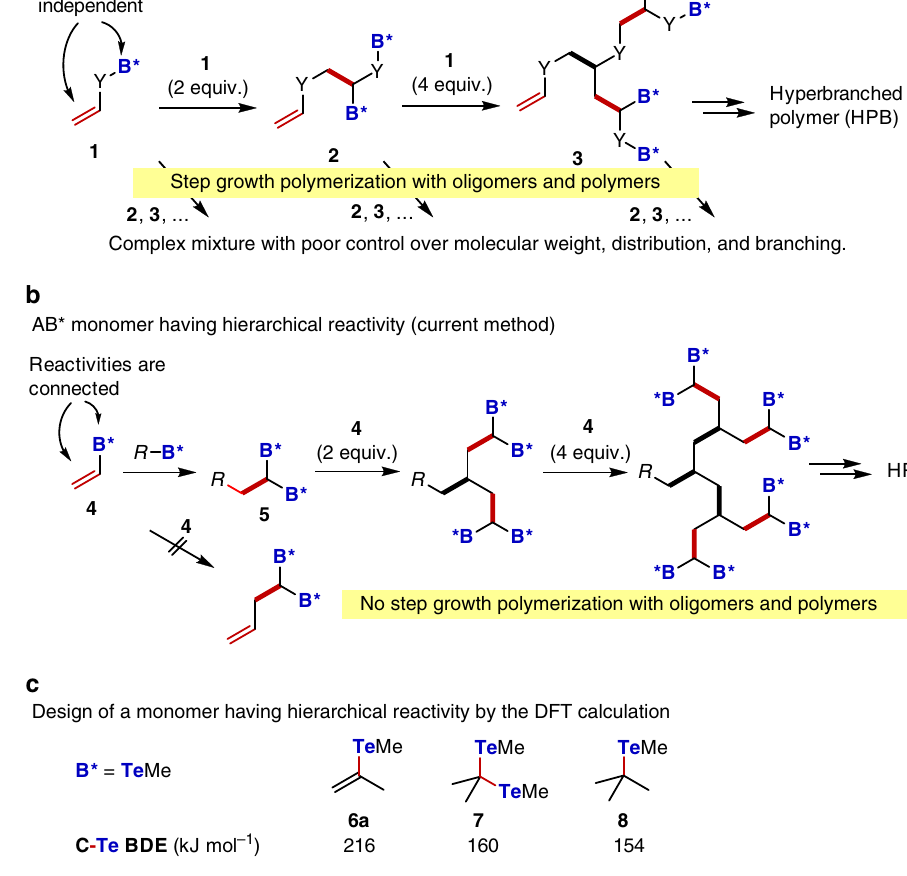
Fig. 1 Synthetic strategy of hyperbranched polymers (HBPs). a The AB* monomer method (self-condensing vinyl polymerization (SCVP)) and b a method using an AB* monomer with hierarchical reactivity. The ole fi n acts as the A functional group, and the bonds originated from the ole fi n in each step are indicated in red for a , b . c Vinyl telluride design. Carbon – tellurium bond dissociation energy (BDE) in kJ mol − 1 obtained by density functional theory calculations at the (U)B3LYP/6-31 G(d,p)(C,H) + LANL2DZ(Te)